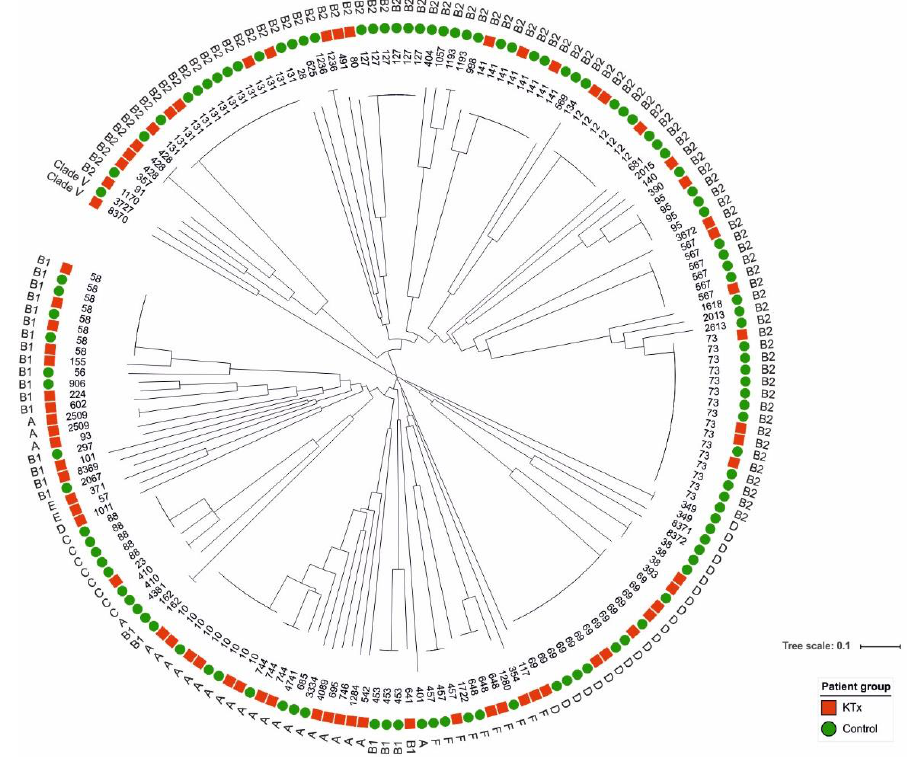
Figure 1. Phylogenetic diversity of the UPEC isolated from KTx and control patients. The neighboring joining tree is based on the MLST of seven housekeeping genes performed with Ridom SeqSphere+ (https://www.ridom.de/seqsphere/) and was created with iTOL (https://itol.embl.de/). The sequence type (ST), the corresponding phylogroup and the isolate group is indicated for each UPEC isolate. The allocation to the two isolate groups (KTx or control) is indicated by different colors.